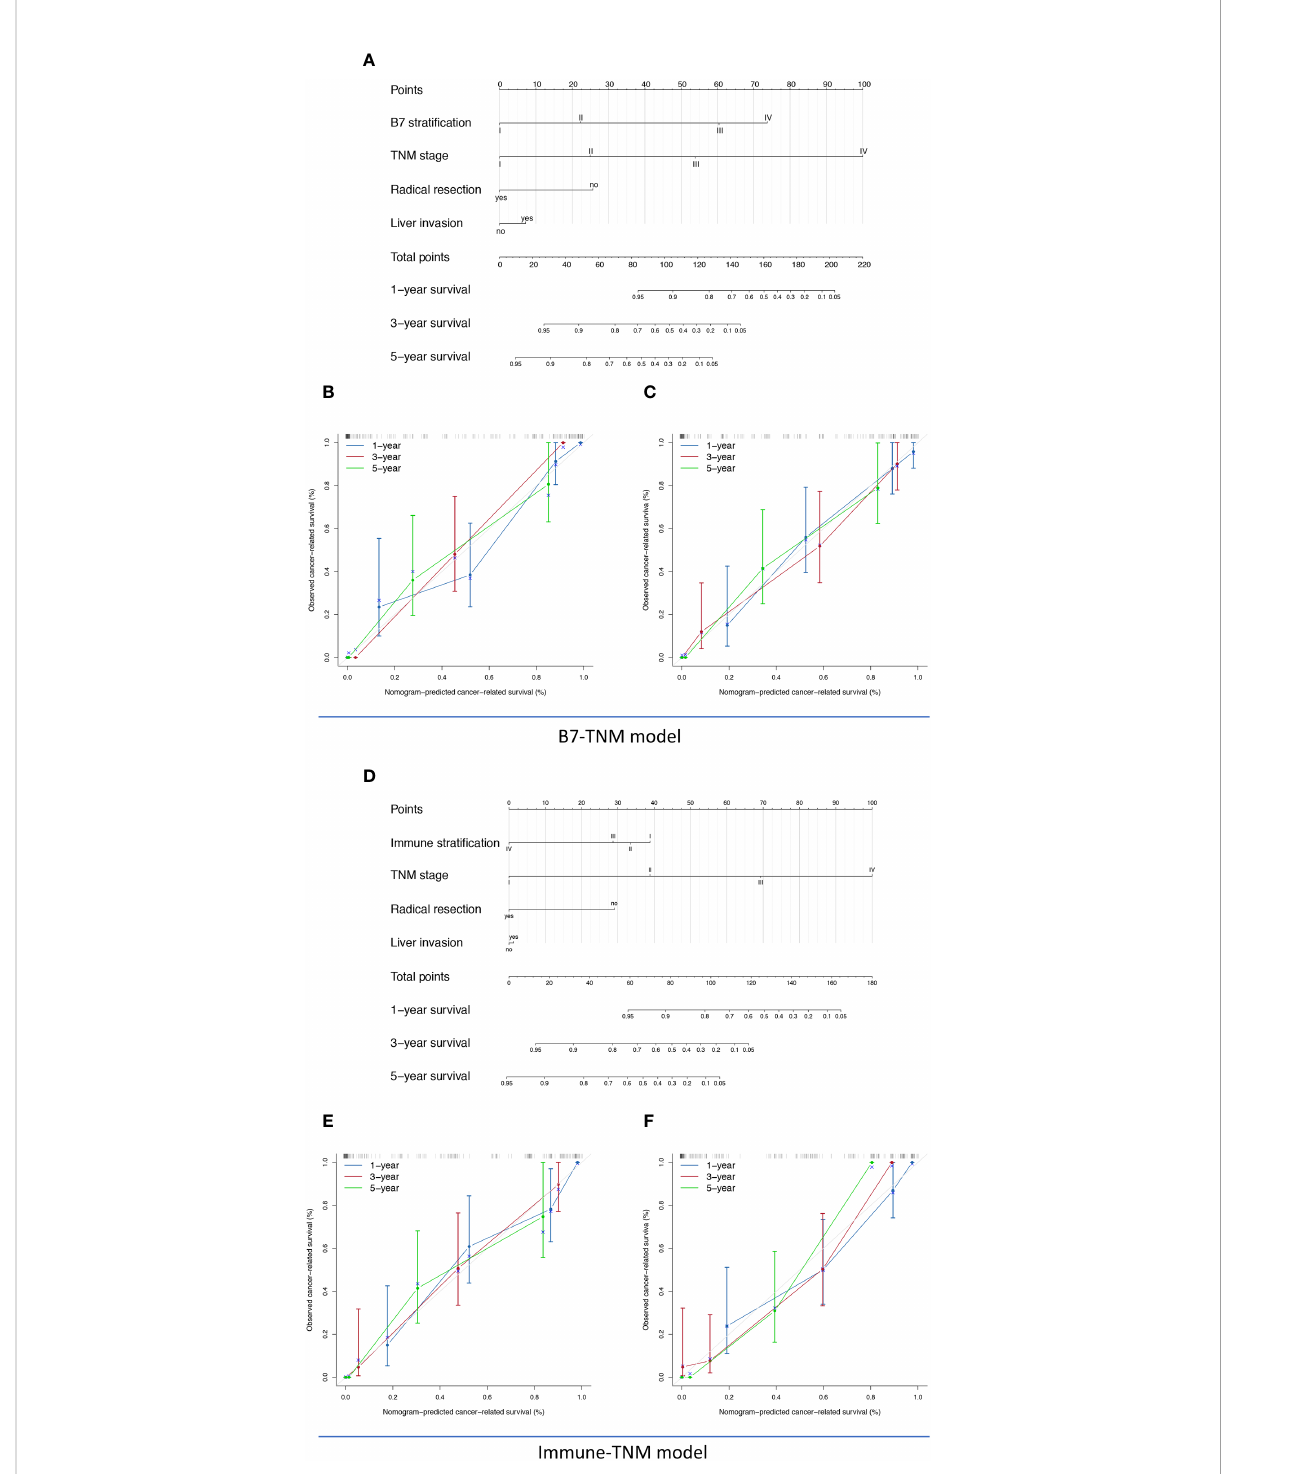
FIGURE 5 The nomogram, calibration analyses, and external validation of the TNM staging system-based prediction model for cancer-related survival (CRS). (A) B7-TNM prediction model established based on TNM stage, B7 strati fi cation, radical resection, and liver invasion; (B) The calibration curve of the B7-TNM model in the internal validation; (C) The calibration curve of the B7-TNM model in the external validation; (D) Immune- TNM prediction model, established based on TNM stage, B7 strati fi cation, radical resection, and liver invasion; (E) The calibration curve of the Immune-TNM model in the internal validation; (F) The calibration curve of the Immune-TNM model in the external validation